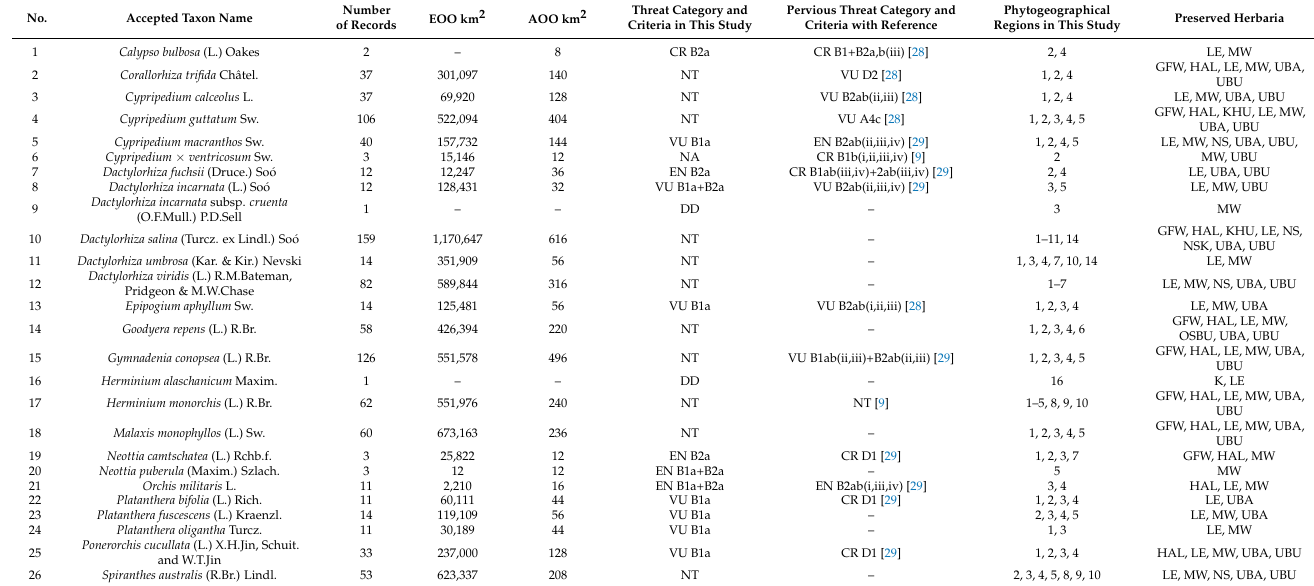
Table 2. The checklist of Orchidaceae in Mongolia with red list assessments, regional distribution, and preserved herbaria. No.